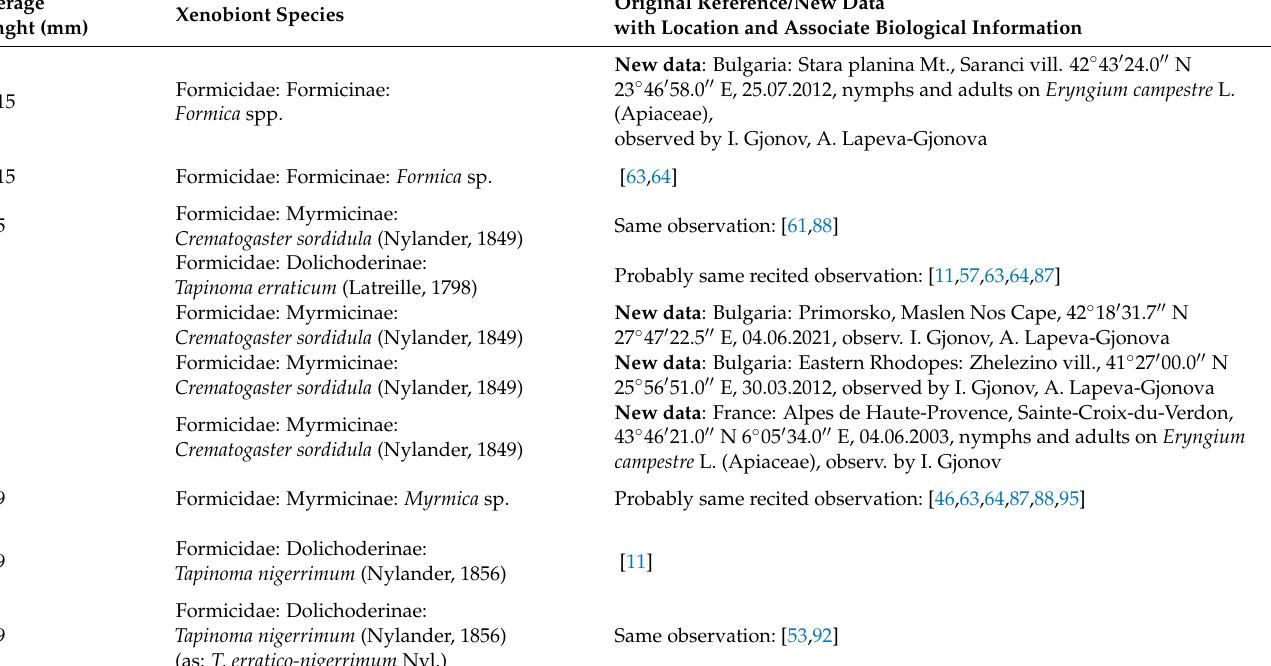
Tettigometra ( Tettigometra )